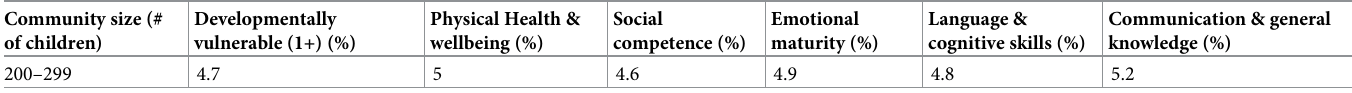
Table 1. Critical differences (%) to establish significant change for each of the six early development